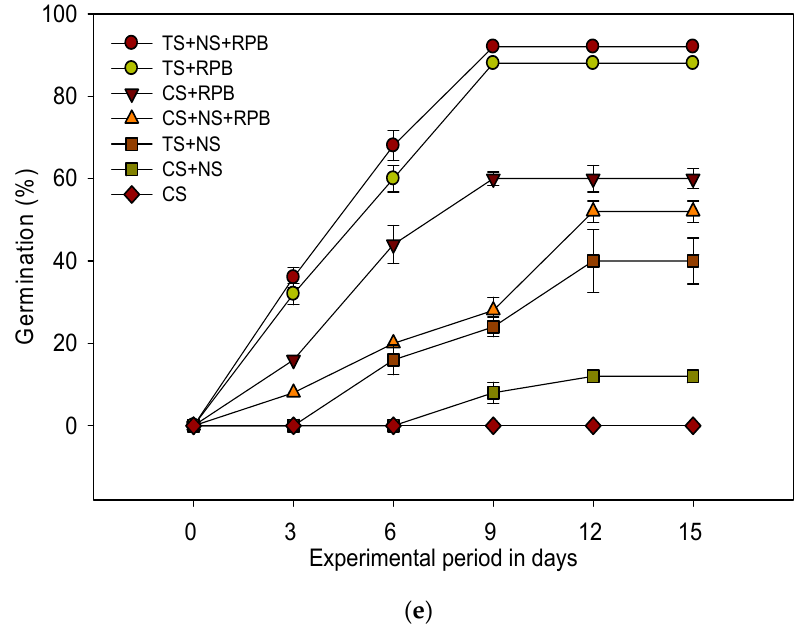
Figure 4. Reduction in the total petroleum hydrocarbon (TPH, %) ( a ) as influenced by different treatments, soil respiration activity (mg CO 2 g − 1 , soil h − 1 ( b ) and soil dehydrogenase activity (mg TPF g − 1 of soil h − 1 ) ( c ). Hydrocarbon-degrading bacterial abundance under different treatments ( d ) Germination rate (%) of red pepper seedlings ( e ) Di fferent lower case letters after values indicate a significant difference at a p -value of 0.05 as determined by DMRT.